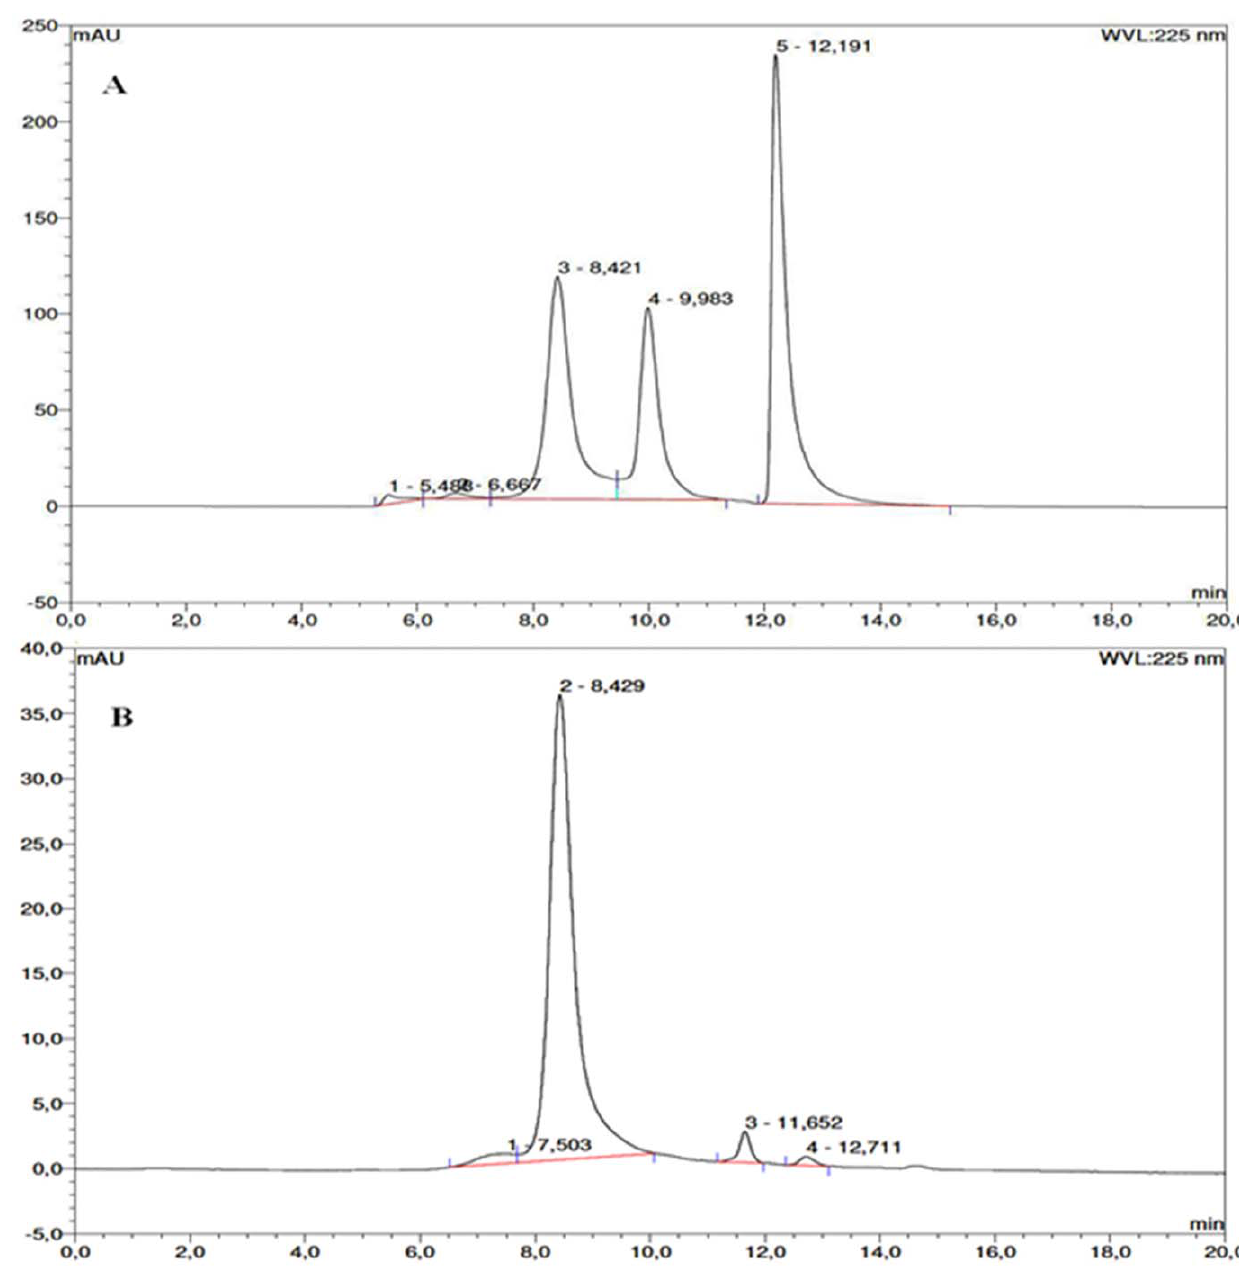
Figure 6. SE-Chromatogram of the sample before and after crystallization. Elution buffer: 0.05 M Tris/0.15 M NaCl, pH 7; flow rate: 1 ml/ min; wavelength: 225 nm. (A) Clarified mAb04c culture supernatant. Peak 3: mAb04c, 8.42 min; Peak 4: Contaminating Protein, 9.98 min; Peak 5: Histidine in buffer, 12.19 min. (B) washed mAb04c crystals, redissolved in 100 mM sodium acetate pH 4.0. Peak 2: mAb04c, 8.43 min.